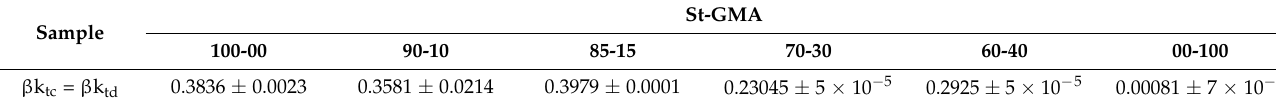
Table 10. AA termination parameters determined in this study.